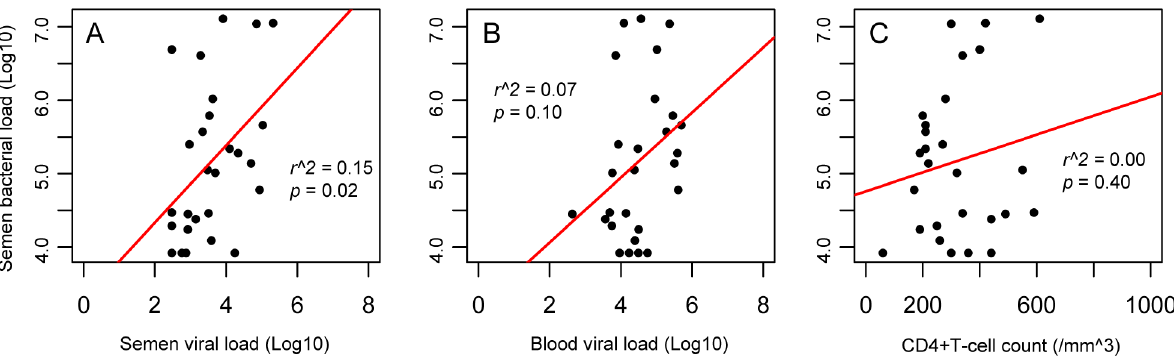
Figure 3. Correlation of semen bacterial load with CD4 + T-cell counts and viral loads in the semen and blood of HIV-infected men prior to antiretroviral treatment. Our data showed multiple correlations between HIV loads and CD4 + counts, including the correlation of semen and blood viral loads and of blood CD4 + T-cell counts and viral load (Figure S1). However, we found that the significant correlation between semen bacterial load with semen viral load was unique (Panel A), and the semen bacterial load showed no such correlation with either the blood viral load (Panel B) or CD4 + T-cell counts (Panel C), suggesting that the correlation between bacterial and viral loads in the semen might be caused by localized